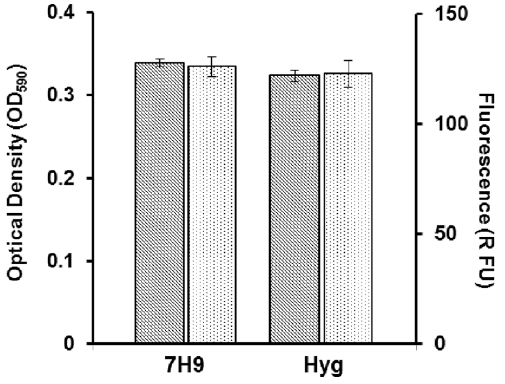
Figure 3. Stability of fluorescent signal in the absence of antibiotic selection. M. tuberculosis CHEAM3 was grown in 100 m L of 7H9-Tw-OADC-H or 100 m L of 7H9-Tw-OADC in 96-well plates. Fluorescence (dotted bars) and optical density (hashed bars) were measured after 5 d of incubation at 37 u C. Measurements are average all of well. Results of 2 independent experiments are shown.